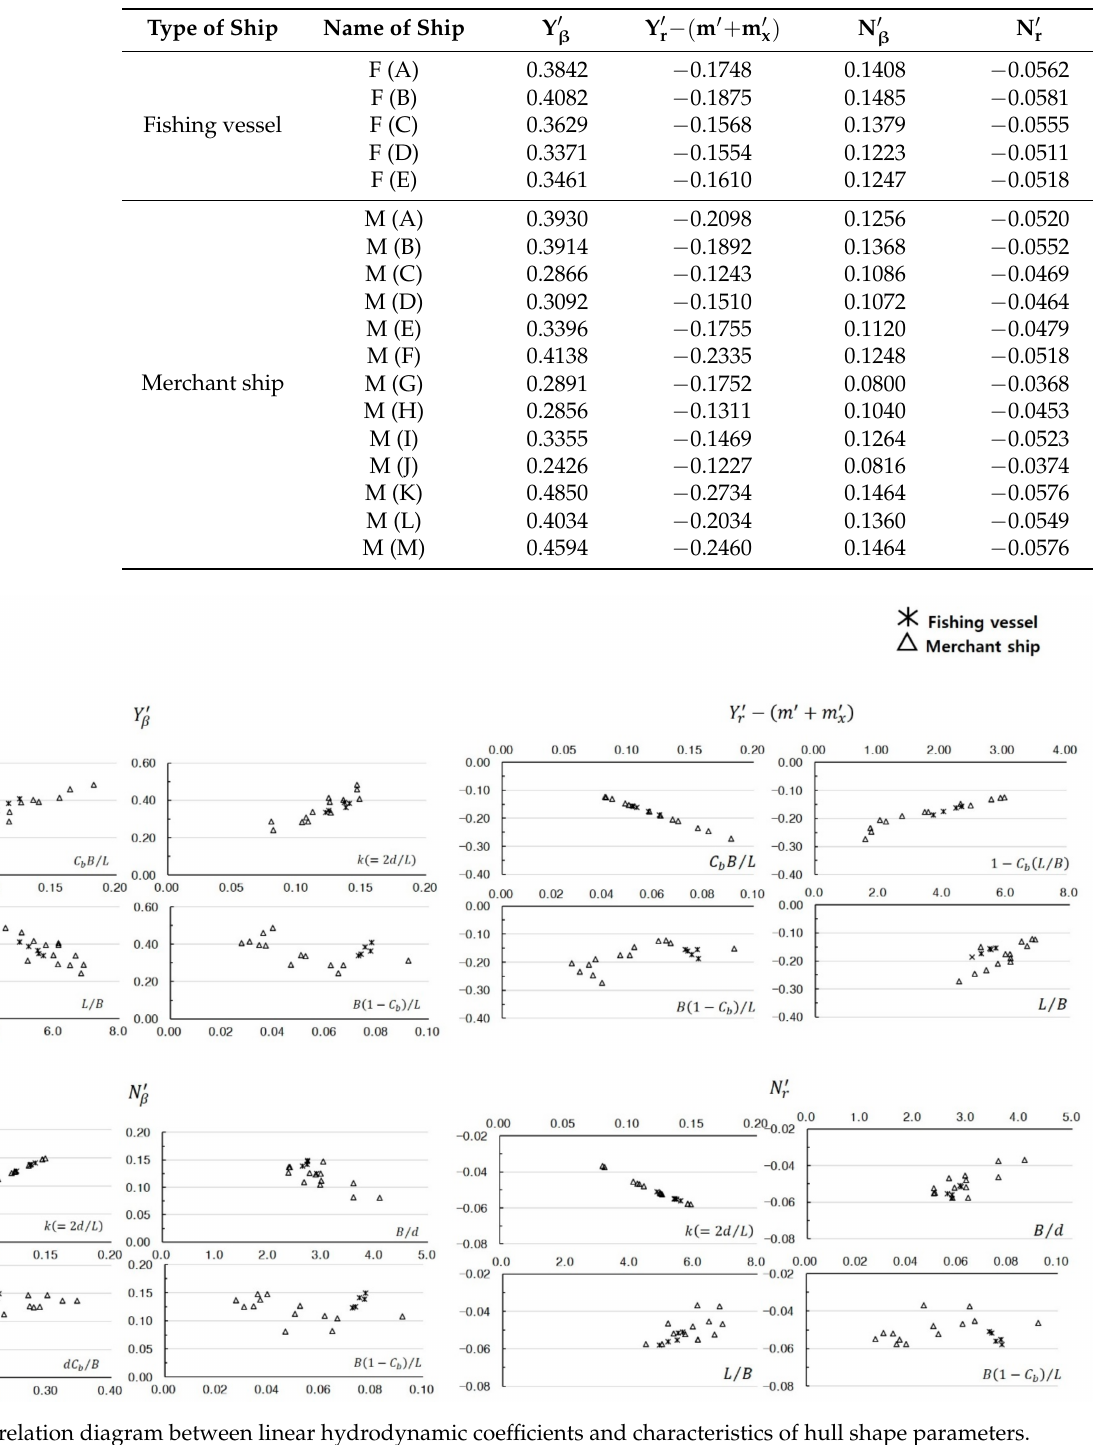
Table 2. Linear hydrodynamic coefficients of 18 vessels.